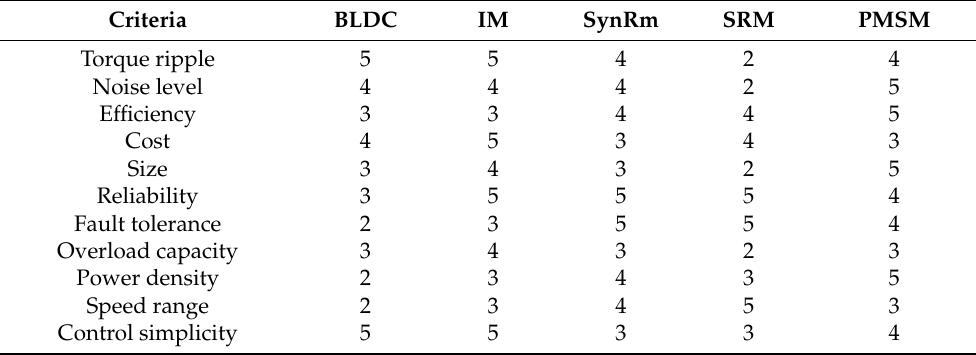
Table 8. Criteria for motor technologies compatibility with hybrid energy storage based on the literature [37,38,97–109].